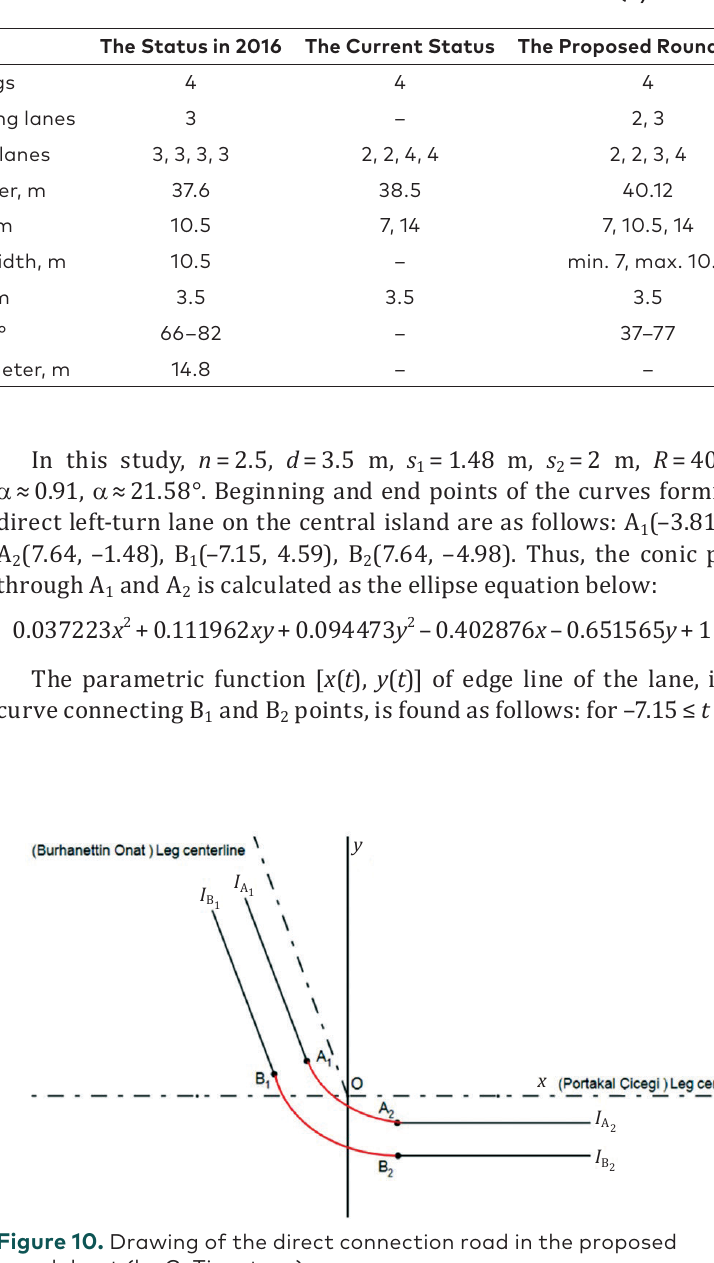
Table 1. Geometric parameters of the roundabout used in the study